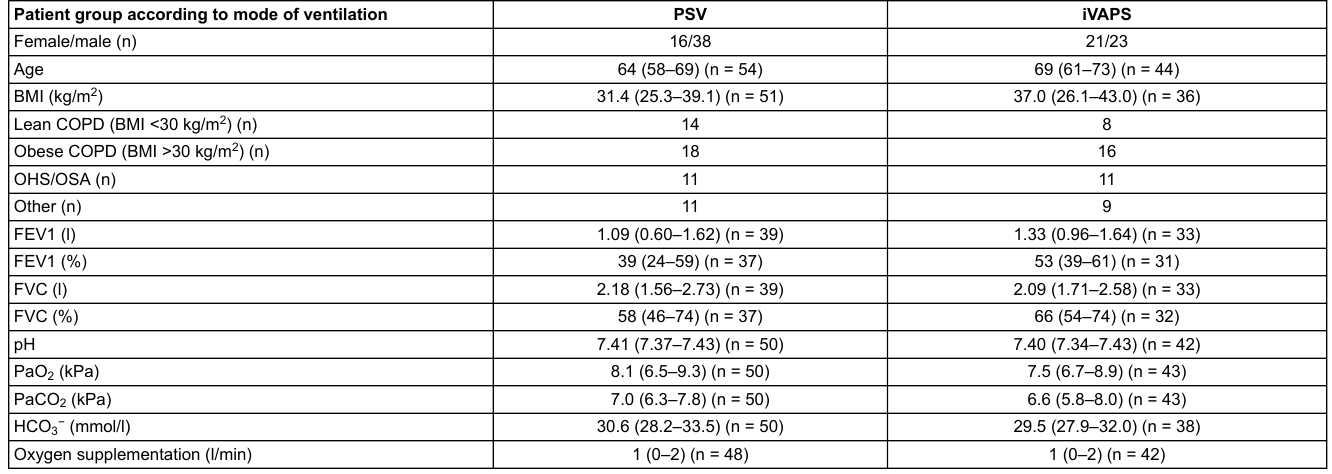
Table 1: Patients’ baseline characteristics.